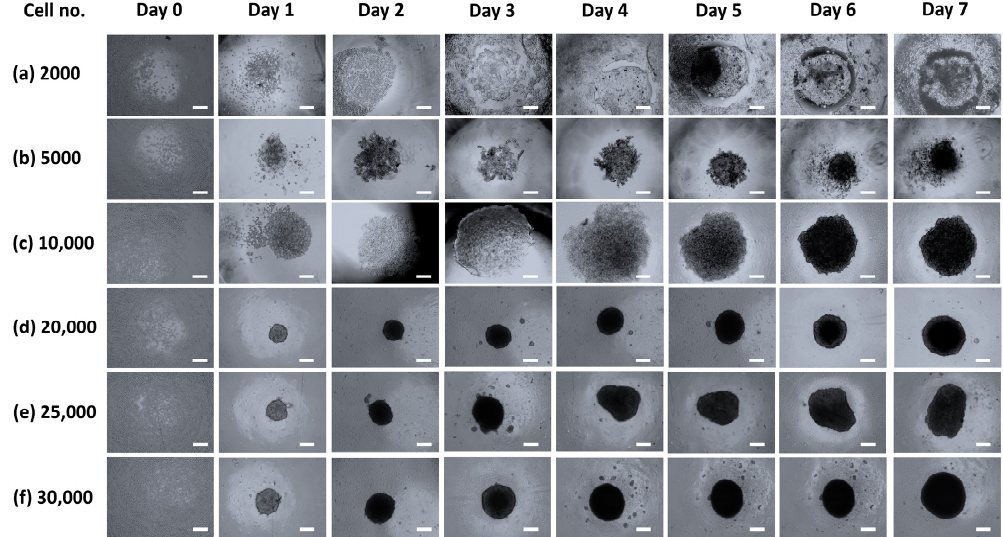
Figure 2. Representative images for cell number optimization; images were captured after each interval of 24 h until 168 h. ( a ) Growth pattern of 2000 cells indicated a failed spheroid formation, ( b ) 5000 cells showed cellular clumps until 96 h, which later transformed into spheroids. ( c ) 10,000 cells successfully indicated spheroid formation after 24 h in comparison with 2000 and 5000 cells. ( d ) 20,000 cell number was found to be the optimum cell number for proper spheroid formation. ( e – f ) 25,000 and 30,000 cell numbers exhibited spheroid formation similar to the cell concentration of 20,000 cells. (Scale: 100 μ m).